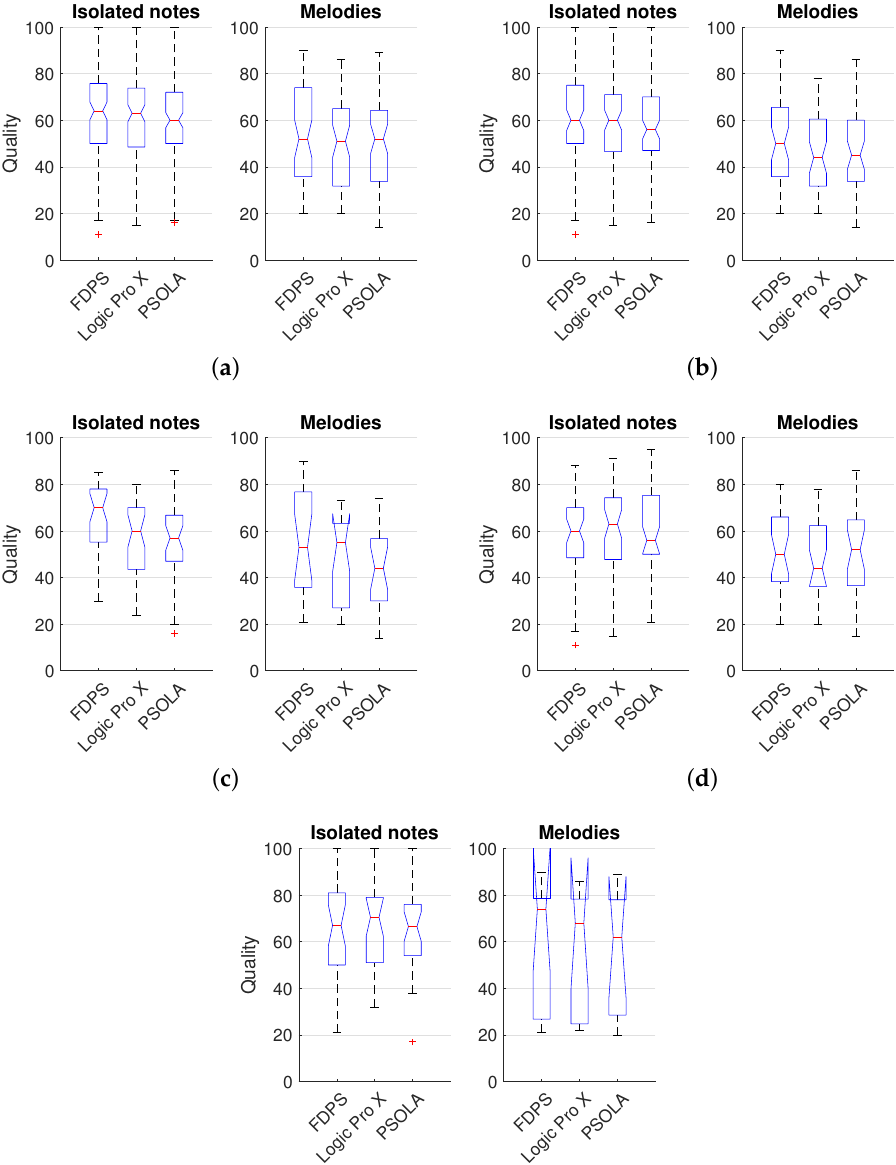
Figure 14. Quality score. Distributions obtained with the survey for isolated notes and melodies. ( a ) Global results including all participants; ( b ) participants using headphones for the test; ( c ) participants with professional music studies or a professional music production background using headphones; ( d ) participants using headphones for the test with elementary music studies or an elementary music production background; ( e ) participants using speakers during the